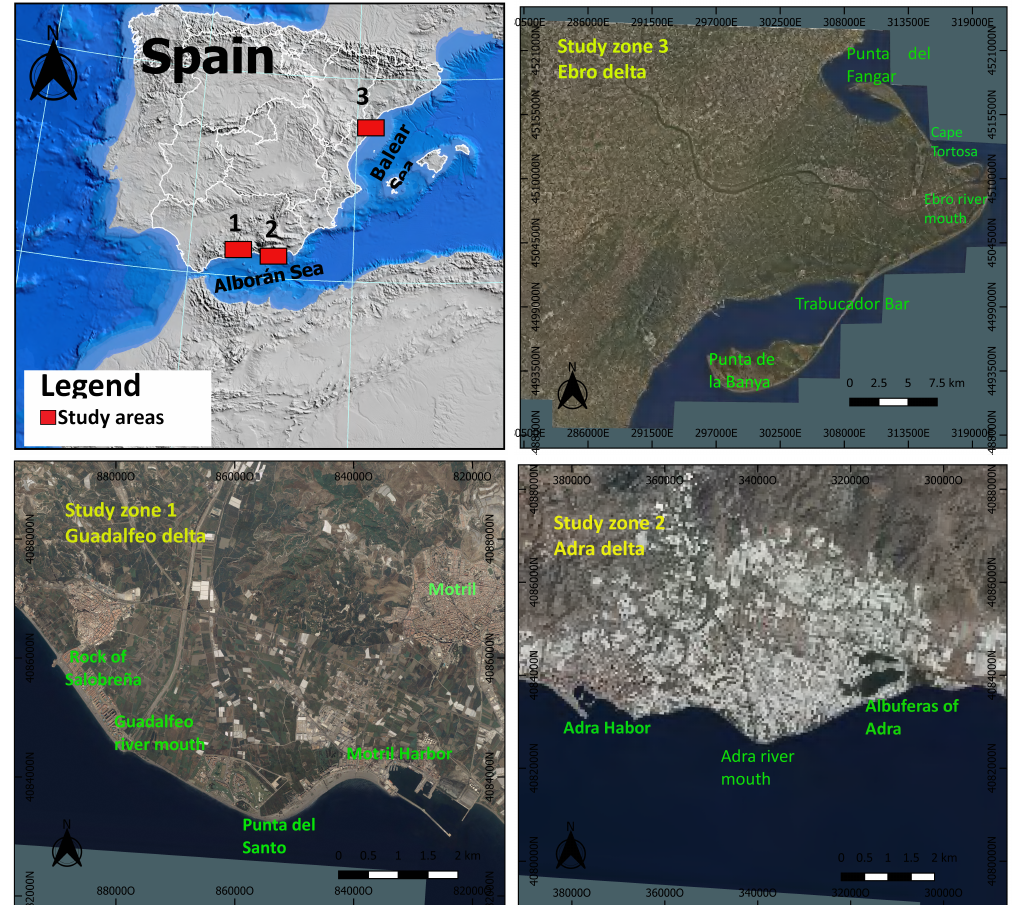
Figure 1. Location map of the three study areas used to validate the